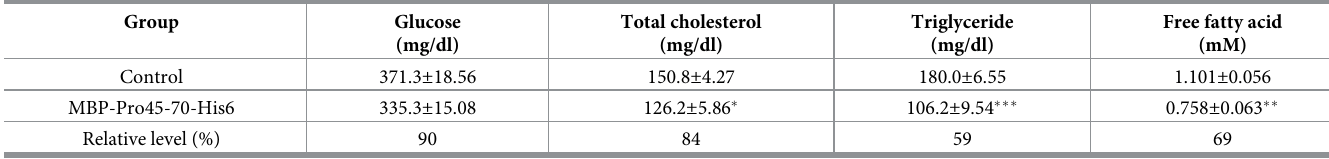
Table 2. Effects of MBP-Pro45-70-His6 on blood glucose, total cholesterol, triglyceride, and free fatty acid level on day 14. Group Control Relative level (%) Relative levels are expressed as percentages of the values to the saline control group. Values are means ± SEM (n = 6). Student‘s t -test was used to compare the mean difference. � p <